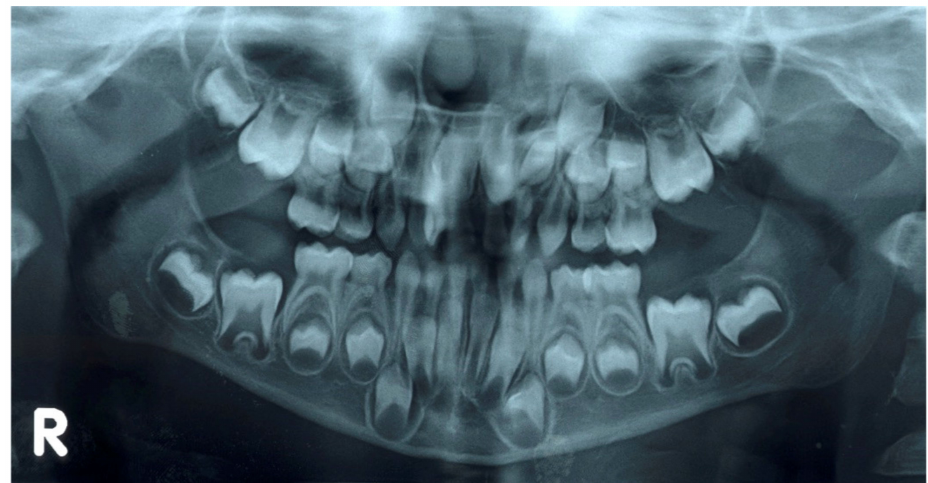
Figure 6. Example of Orthopantomography of patient with supernumerary